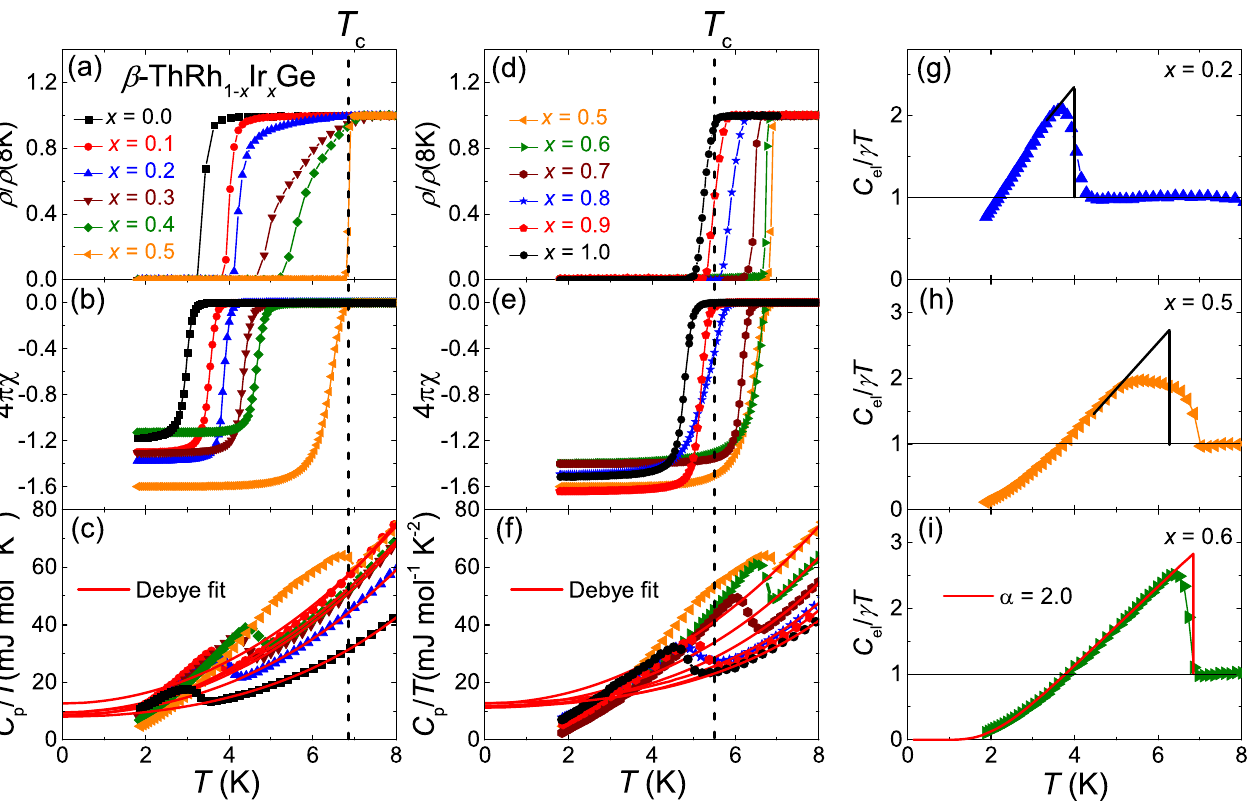
Fig. 3 Evolution of superconductivity in β -ThRh 1 − x Ir x Ge. a – c Low-temperature resistivity, magnetic susceptibility and speci fi c heat, respectively, for the β -ThRh 1 − x Ir x Ge samples with x ≤ 0.5. The vertical dashed line indicates the T c for x = 0.5, and the solid lines in ( c ) are fi ts to the normal-state data by the Debye model. d – f Same set of data for the samples with x ≥ 0.5. The vertical dashed line indicates the T c for x = 0.9. g – i Normalized electronic speci fi c-heat data plotted as a function of temperature for the samples with x = 0.2, 0.5, and 0.6, respectively. In ( a , b ), the solid lines are entropy conserving constructions to estimate the size of speci fi c-heat jump. In ( c ), the solid curve is a fi t to the data by the α -model with α =